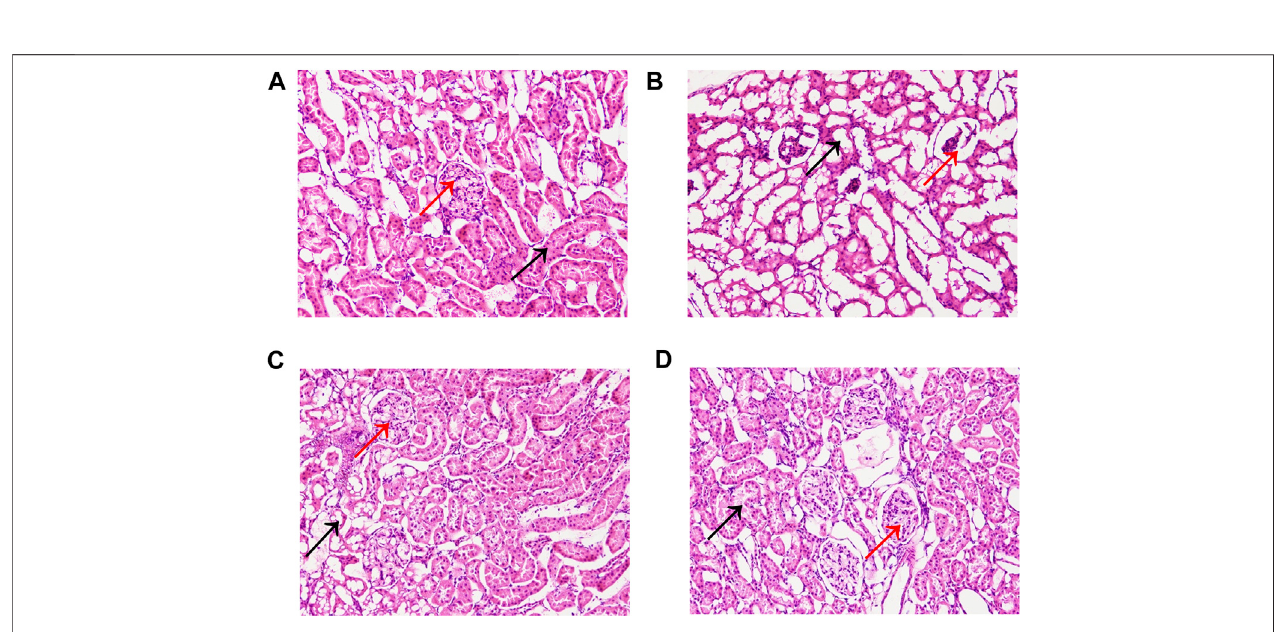
FIGURE 4 | Representative micrographs of histopathology in each group at magni fi cation × 200. Black arrows represent kidney tubules, and red arrows represent glomeruli. (A) control group (B) model group (C) benazepril group (D) QRKSG group.